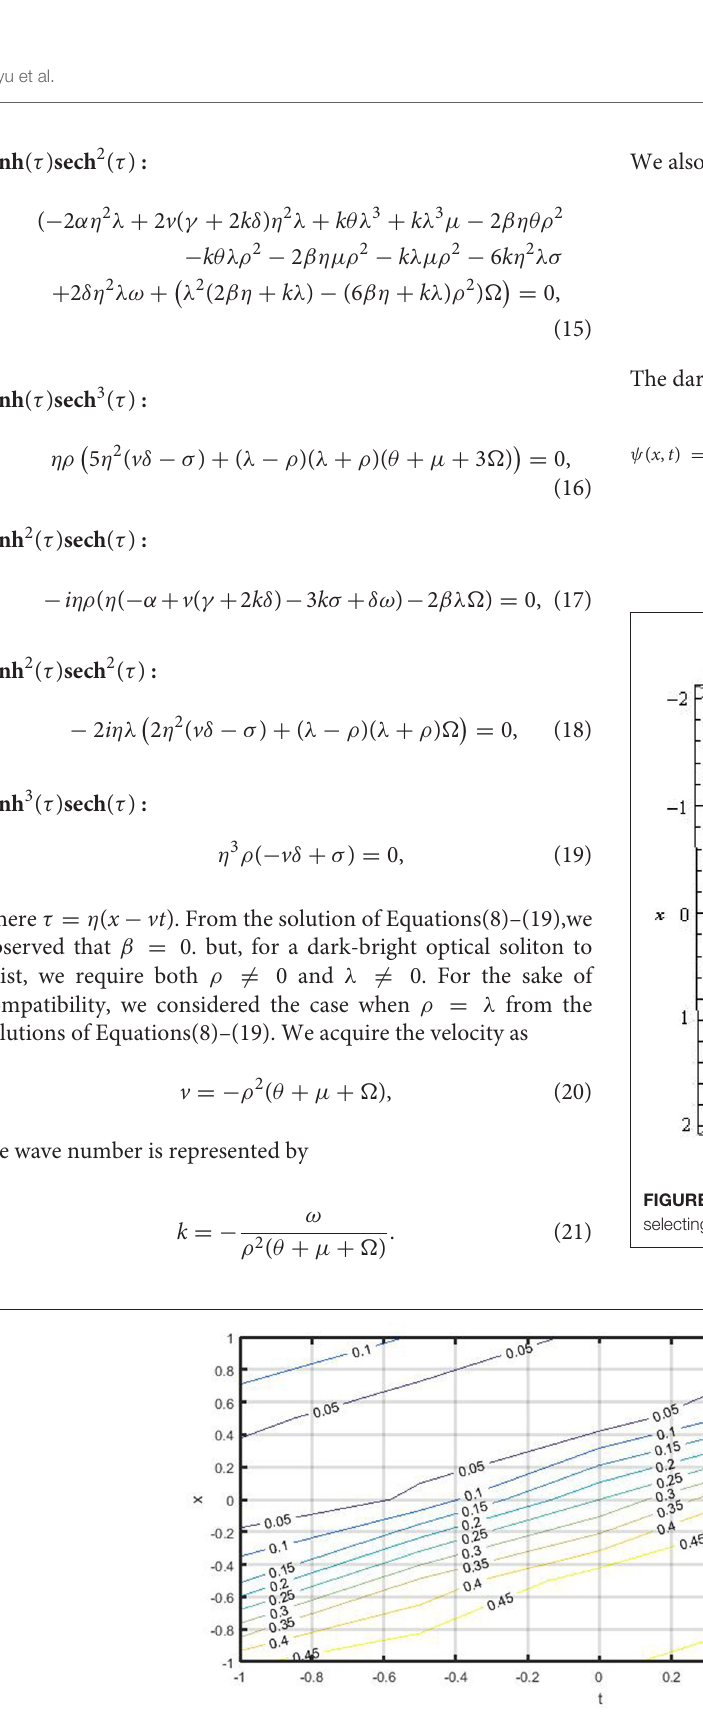
FIGURE 2 | The contour surface of solution Equation (24) by selecting the parameter values of η = 0.1, λ = 0.1, θ = 1, (cid:127) = 0.1.